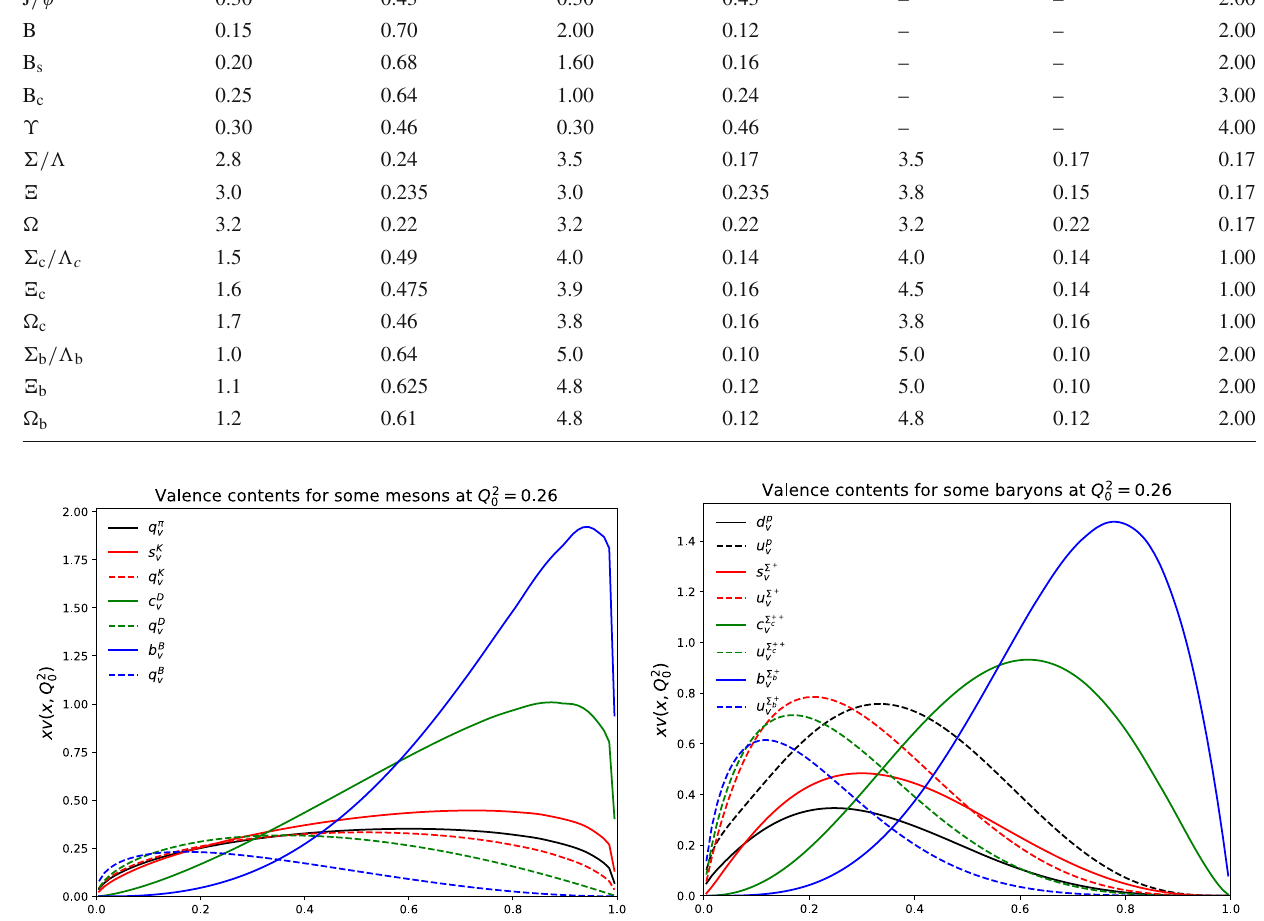
Fig. 4 Different valence PDFs at the initial scale Q 2 valence contents; and for (b) uu q baryons for q = d (proton), s ( (cid:9) + ), c ( (cid:9) ++ c ) and b ( (cid:9) +